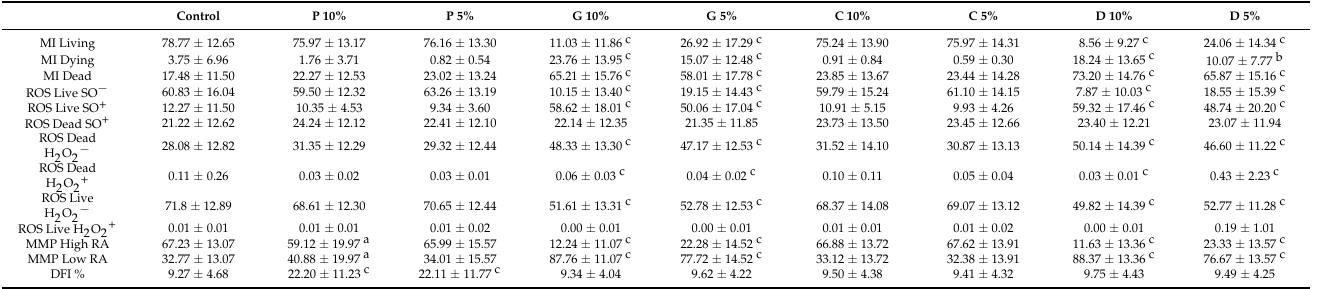
Table 3. Flow cytometry results of bull semen samples at Time 1 after exposure to various plant-based